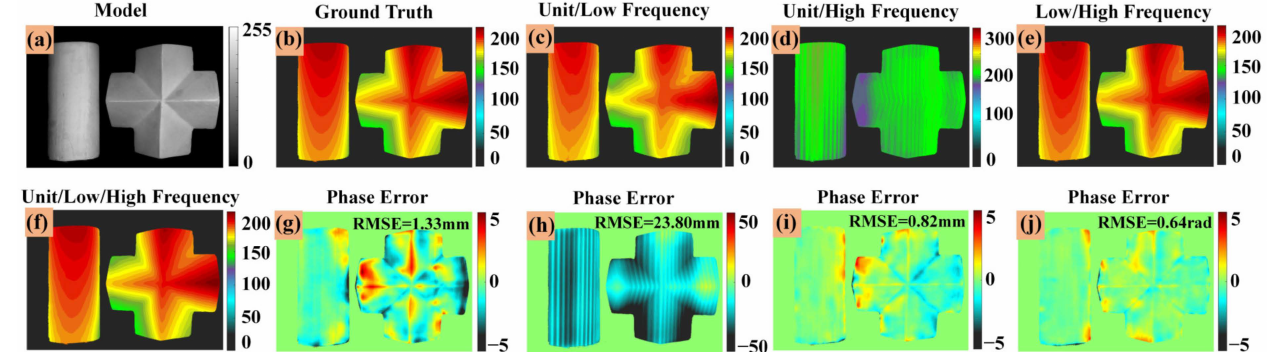
Figure 9. 3D reconstruction results of different number of fringe images. ( a ) Reconstructed object (scenario 1). ( b ) Depth map (ground truth). ( c ) Depth map (unit/low frequency). ( d ) Depth map (unit/high frequency). ( e ) Depth map (low/high frequency). ( f ) Depth map (unit/low/high fre- quency). ( g ) Depth error map (unit/low frequency). ( h ) Depth error map (unit/high frequency). ( i ) Depth error map ((low/high frequency). ( j ) Depth error map (unit/low/high frequency).